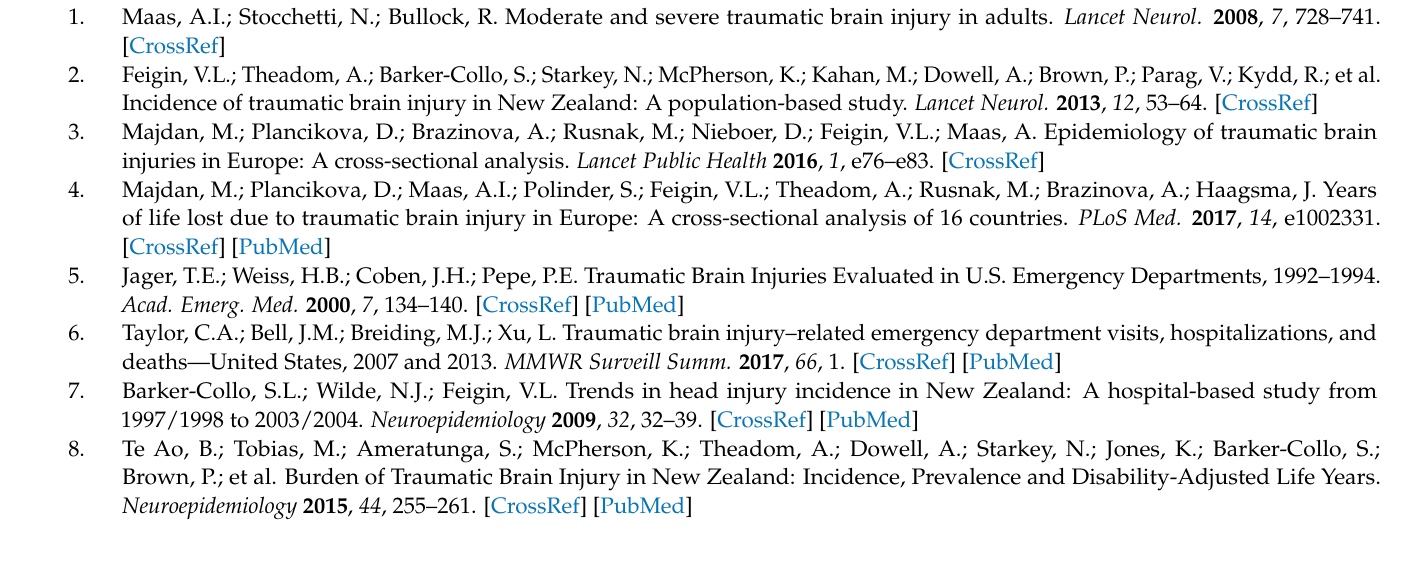
sexes combined. Figure S5: Crude and age-standardized rates of TBI-related in-patient (A) and day cases (B) hospital discharges with estimated pooled rates for the analyzed 30 European countries in 2014, in boys. Figure S6: Crude and age-standardized rates of TBI-related in-patient (A) and day cases (B) hospital discharges with estimated pooled rates for the 30 analyzed European countries in 2014, in girls. Figure S7: Distribution of external causes of death due to TBI) among 0–19 year-olds in 30 European countries by country, both sexes combined, in 2014. Table S1: Case definitions of TBI related deaths, external causes of deaths and hospital discharges due to TBI. Table S2: Availability of the data on hospital discharges and deaths due to TBI per country. Table S3: Sex ratios of hospital discharges, deaths and YLLs by country. Table S4: Proportions (%) of external causes of death due to TBI among 0–19 year-olds in 30 European countries by country, both sexes combined, in 2014. Table S5: Estimated numbers of hospital discharges, deaths and YLLs to TBI extrapolated to the population of 0–19 year-olds in the European Union for 2014, by